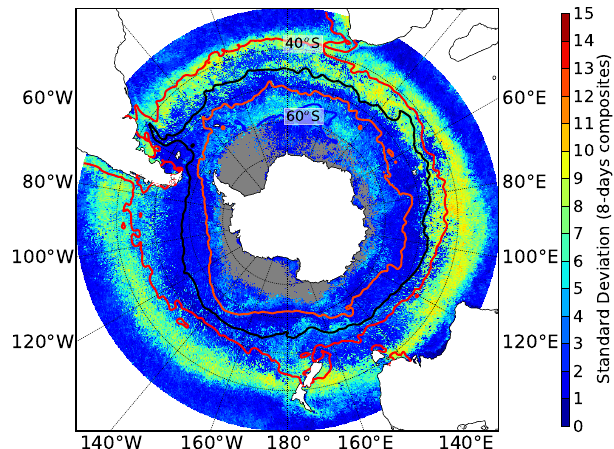
Fig. 3. Inter-annual variability (standard deviation over the 9yr) in phytoplankton bloom initiation dates (units in 8-day composites) for the Southern Ocean south of 30 ◦